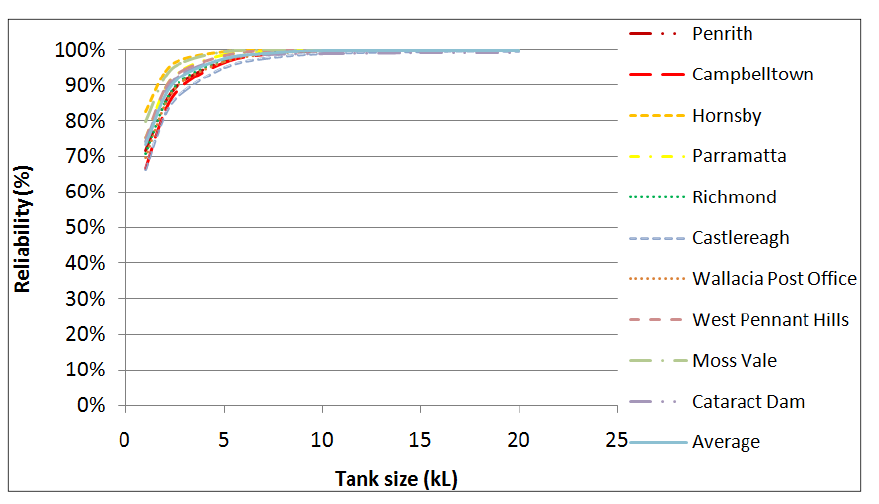
Figure 3. Reliability of RWHS at ten selected locations using rainwater for toilet and laundry use (considering the daily rainfall data of all the years on